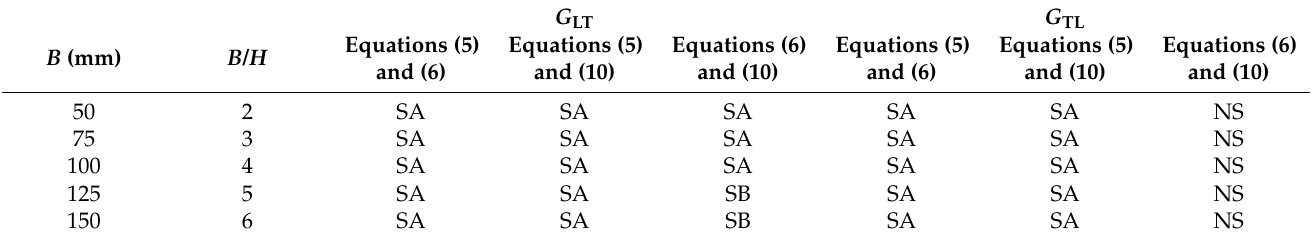
SA and SB indicate that the significance levels are lower than 0.01 and 0.05, respectively, whereas NS indicates that the significance level is greater than 0.05. Table 4 lists the average values of G LT and G TL . The G LT and G TL values